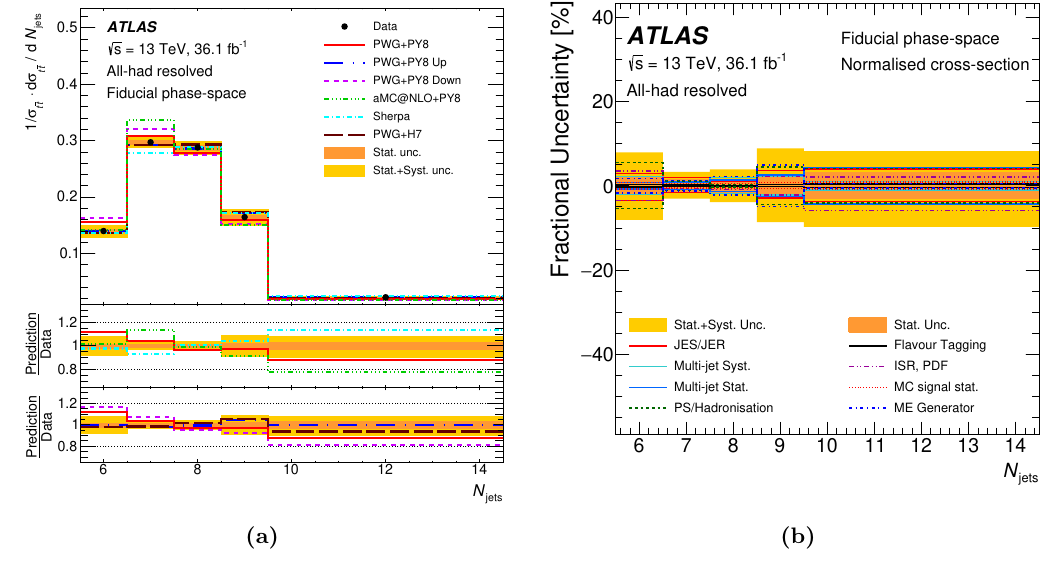
Figure 11 . Single-differential normalised cross-section measurements (a), unfolded at particle level, as a function of the jet multiplicity. In the top panel, the unfolded data are shown as black points, while lines indicate the predictions from several MC programs. Uncertainties are shown by the shaded bands. Data points are placed at the centre of each bin. The lower two panels show the ratio of the MC predictions to the unfolded data. Fractional uncertainties (b) for the normalised single-differential distributions unfolded at particle level as a function of the jet multiplicity. The bands represent the uncertainties in the unfolded data. Lines indicate the breakdown of the major components of the